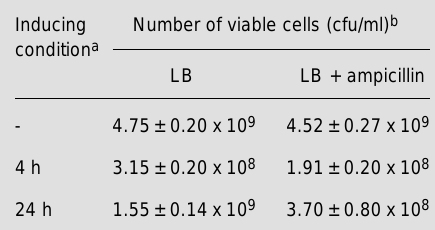
Table 1 - Evaluation of pCFA-1 stability in HG3 cells grown under inducing conditions. a Exponential phase HG3 cells were incubated in the presence of 0.5 mM IPTG for 4 or 24 h. b Results are reported as the mean ± SD of qua- druplicates from two identical experiments.